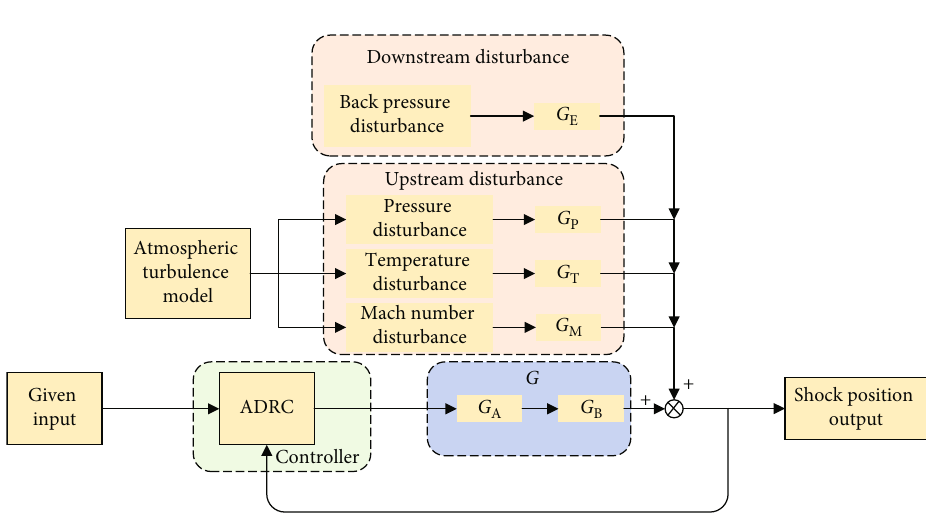
Figure 10: Normal shock position closed loop